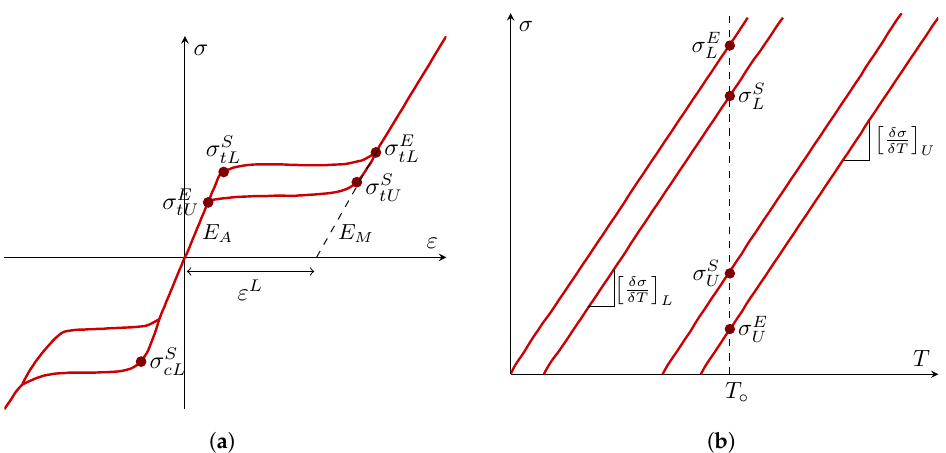
Figure 9. ( a ) Uniaxial response of a superelastic material and ( b ) stress–temperature curve of a super- elastic material.